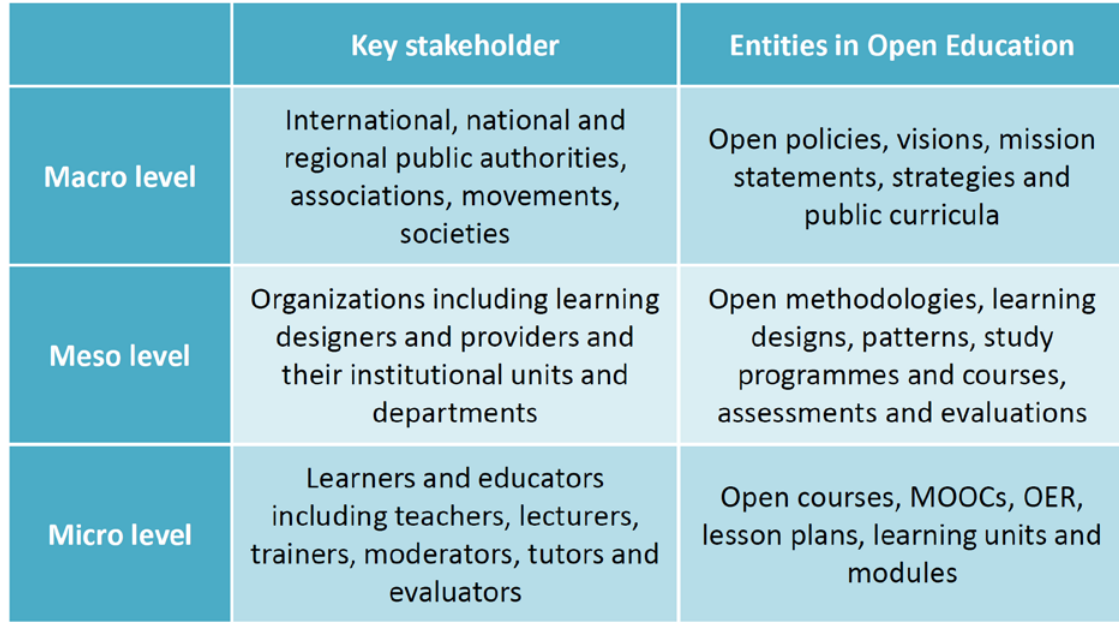
Key Stakeholders and Entities in Open Education at the Three